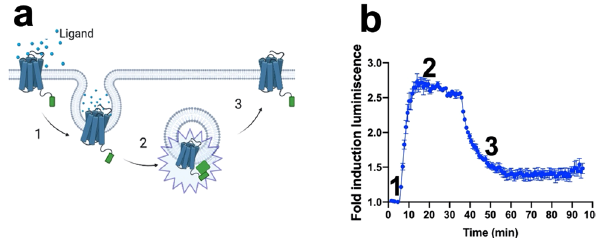
Fig. 2 Monitoring in real-time the internalization and recycling of a prototypical GPCR. a , b Recycling of β 2AR in HEK293 cells using 10 µ M epinephrine; Number “ 1 ” indicates the receptor being removed from the plasma membrane, Number “ 2 ” corresponds to the receptor being localized in early endosomes, and Number “ 3 ” indicates the washout of the ligand and return of the receptor to the cell surface. The arrows indicate the time at which the cells were treated with the corresponding ligand. The results are expressed as mean ± s.e.m. of three experiments performed in triplicate;